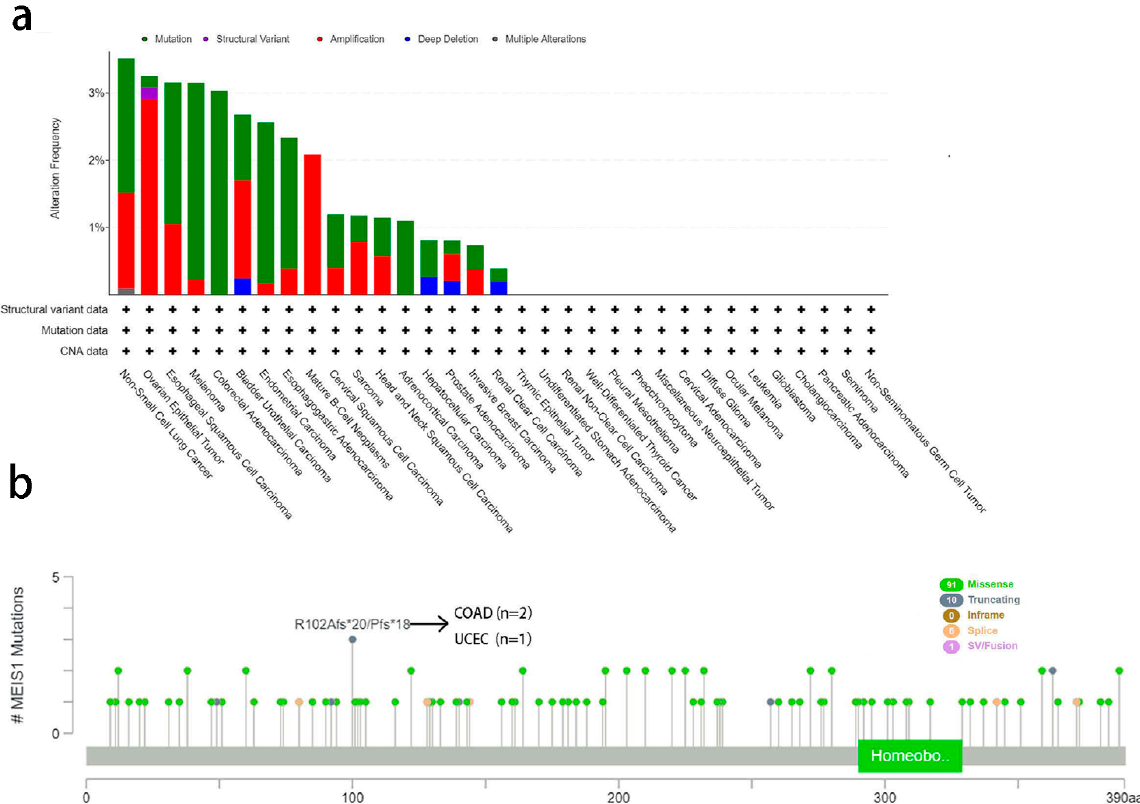
Figure 3. MEIS1 gene alteration frequency, types, sites and cases. ( a ) MEIS1 alteration types and frequency. ( b ) MEIS1 mutation types, sites and cases. “+” represents that data are available. 3.4. Phosphorylation and Promoter Methylation Expression of MEIS1 across Different Cancers Changes in phosphorylation pathway are closely related to cancer. Based on the CPTAC dataset, breast cancer, ovarian cancer, colon cancer, ccRCC, UCEC, LUAD and pediatric brain cancer were included to explore phosphorylation level between their tumor tissues and normal tissues. Ultimately, the box plots of four types of cancer are available in Figure 4a. In ovarian cancer, MEIS1 phosphoprotein level (S194, S196 and T202) between tumor and normal tissues has no statistical differences, while the phosphorylation level of S196 in LUAD ( p < 0.001), ccRCC ( p < 0.001) and UCEC ( p < 0.001) were higher in normal tissues compared to tumor tissues. More experiments evidence is needed to identify the function of MEIS1 phosphorylation at the S196 site in tumorigenesis. In addition, it is found that promoter methylation level of MEIS1 in BLCA, HNSC, KIRC, KIRP, PRAD and UCEC were lower in primary tumors compared to normal tissues ( p < 0.05) (Figure